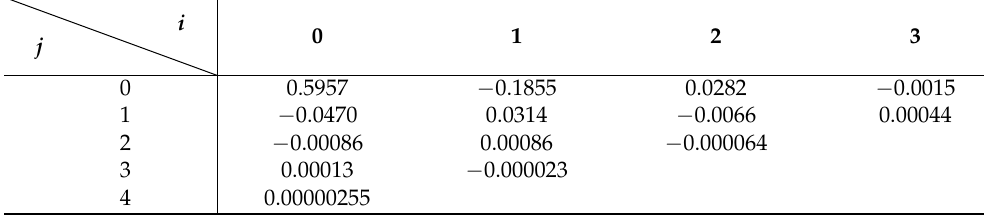
Table 2. Fitting coefficients of C D